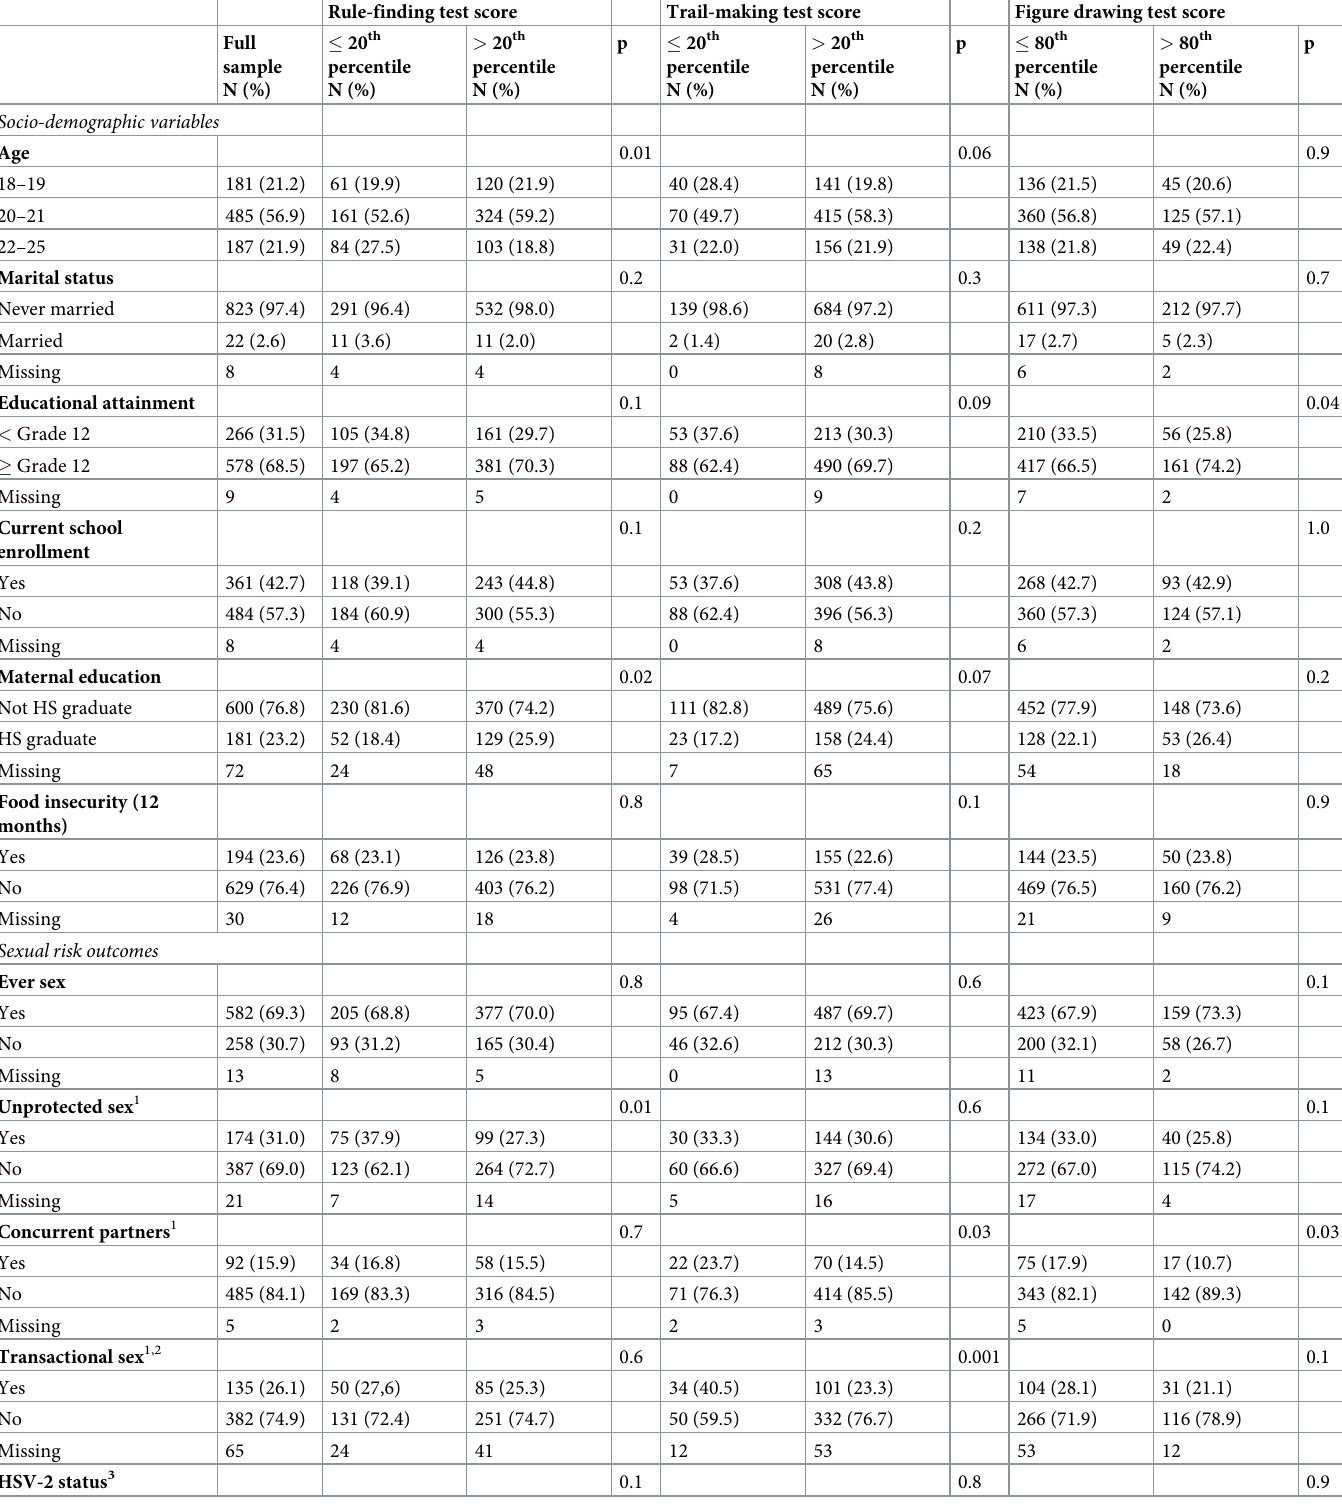
Table 1. Socio-demographic and sexual risk characteristics of young women, by executive function test scores, rural South Africa, 2013–2015. Rule-finding test score Trail-making test score Figure drawing test